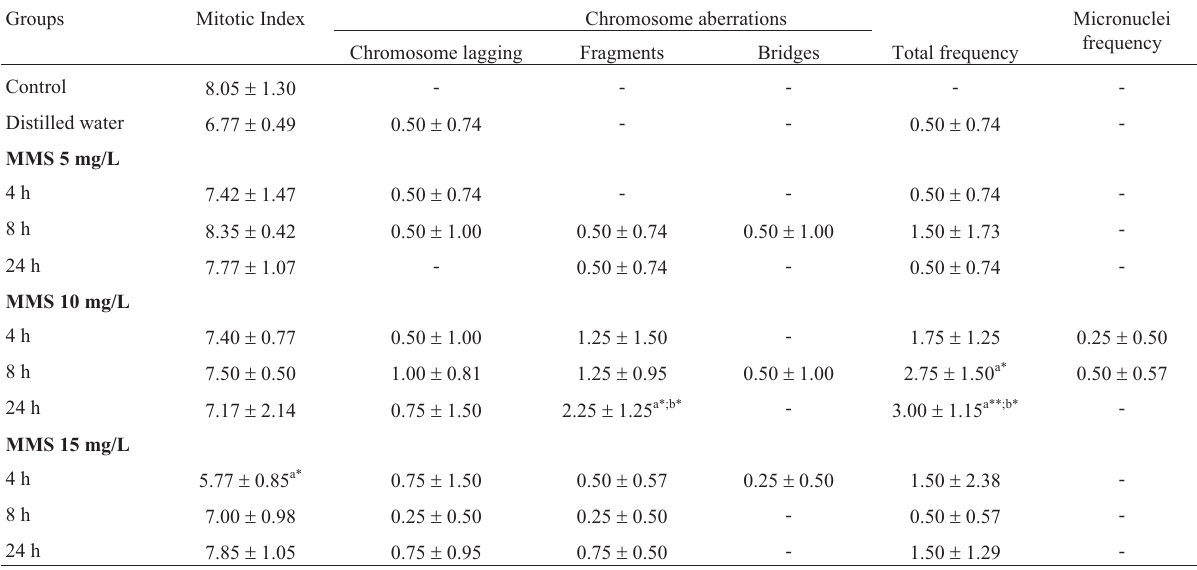
Table 2 - Mitotic index, frequency of chromosome aberrations and of micronuclei obtained in the cytogenetic tests on cells from the meristematic region (n = 4000) in roots of Oryza sativa L. accession BGA008070 “Primavera” exposed to methyl methanesulfonate (MMS).